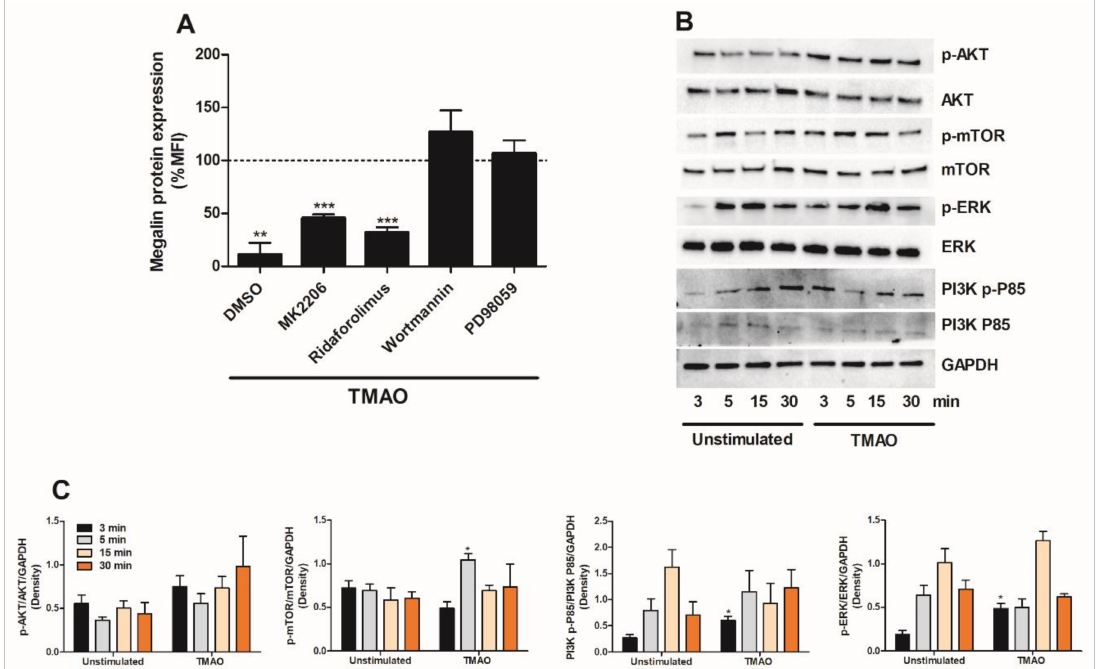
Figure 6. PI3K and ERK mediate TMAO-induced suppression of megalin expression. HK-2 cells were pre-incubated with DMSO (vehicle), Akt inhibitor MK-2206 (1 µ M), mTOR inhibitor ridaforolimus (1 µ M), PI3K inhibitor wortmannin (1 µ M) or ERK inhibitor PD98059 (1 µ M) for 1 h prior to TMAO stimulation (300 µ M) for 24 h ( A ) followed by evaluating megalin protein expression with flow cytometry. Megalin protein expression is presented as % of vehicle control (DMSO or respective inhibitor alone), which is represented by the dotted line. Western blot analysis was conducted to identify differences in protein levels of p-Akt/Akt, p-mTOR/mTOR, p-ERK/ERK and PI3K p- P85/PI3K P85 after TMAO (300 µ M) stimulation for 3, 5, 15 and 30 min ( B , C ). GAPDH was used as a loading control. Data are presented as mean ± SEM (n = 3 independent experiments). MFI, mean fluorescence intensity. Asterisks denote statistical significance compared to unstimulated cells (* p < 0.05, ** p < 0.01, *** p <